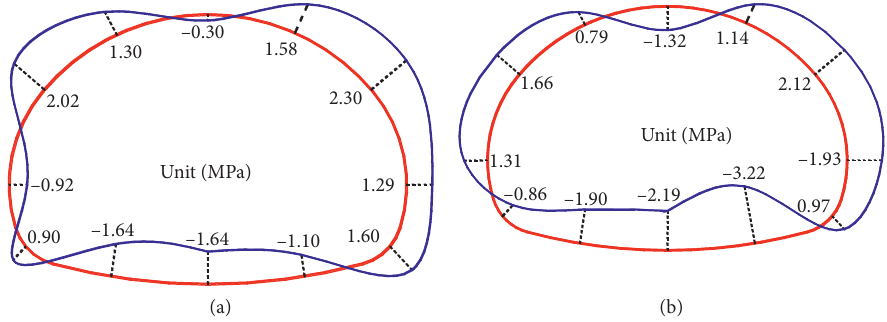
Figure 20: Stress distribution of secondary lining concrete of YK2+133 section. (a) Maximum stress value of outside concrete. (b) Maximum stress value of inside